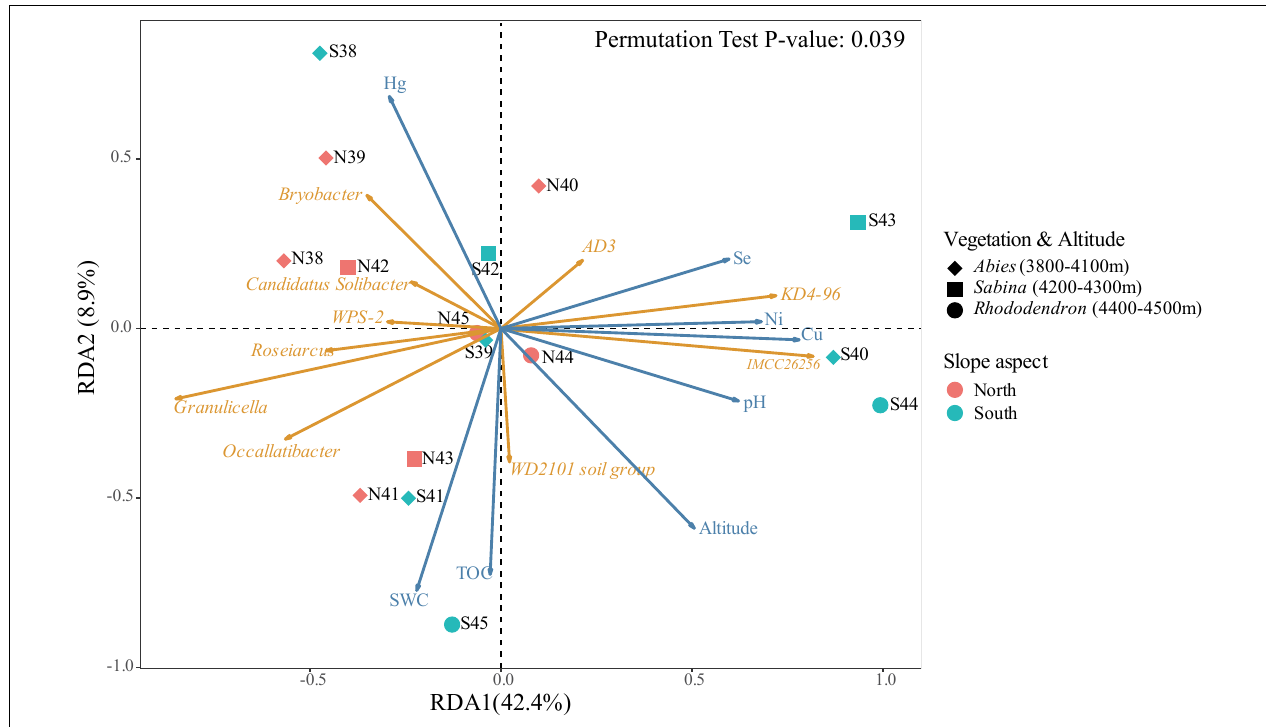
FIGURE 4 | Distance-based redundancy analysis (db-RDA) of bacterial communities and environmental factors in the soils of Mt. Shergyla. The point colors indicate the mountain slopes of sample collection. The point shapes represent the aboveground plant species. The blue and orange arrows represent environmental factors and soil bacterial genera, respectively, and the cosine of the angle within two vector arrows represents the correlation between the